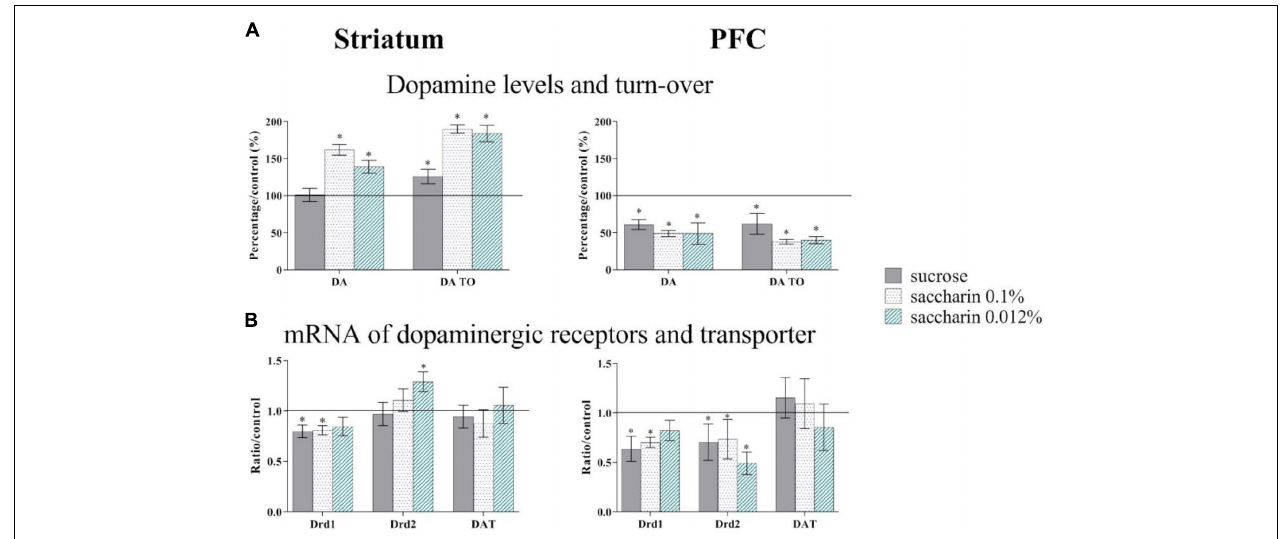
FIGURE 5 | 1% sucrose (gray bars), 0.1% saccharin (point bars) and 0.012% saccharin (striped bars) impact on dopamine levels (DA) and turn-over (TO) in HPLC quantifications (A) and on Drd1 (Dopamine receptor D1), Drd2 (Dopamine receptor D2) and DAT (Dopamine transporter) mARN (messenger ribonucleic acid) expression in RT qPCR (B) in the prefrontal cortex (PFC) and the Striatum. ∗ p < 0.05. Adapted from Hamelin et al., 2021.